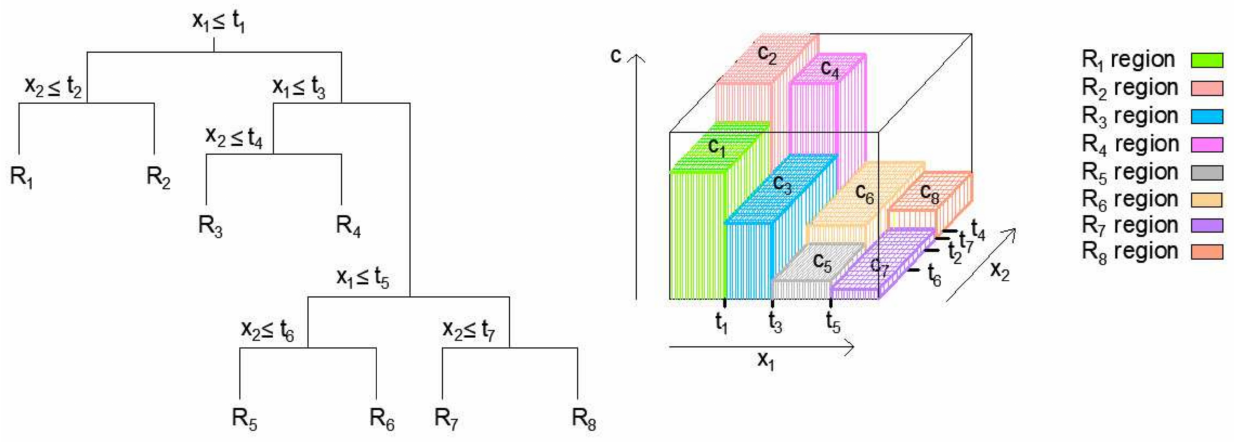
Figure 4. Example of the segmentation of variable spaces into regions and 3D regression surfaces for the created regression tree